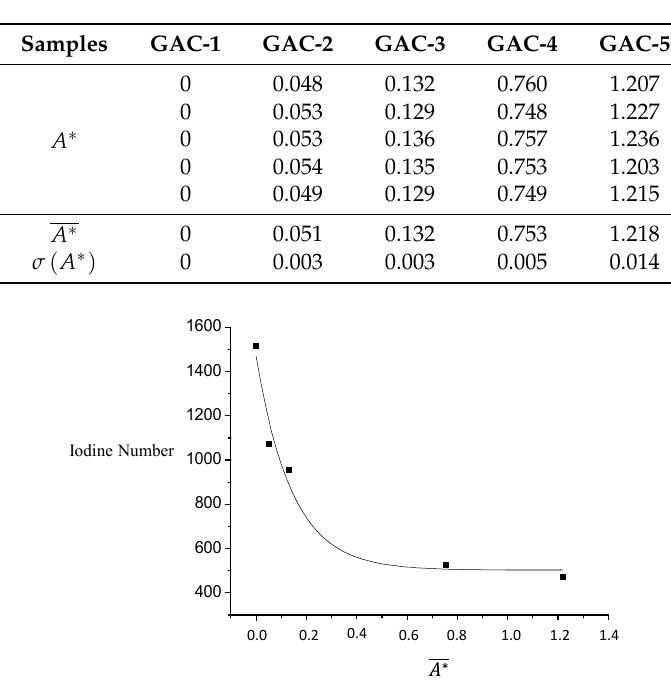
Table 10. A* values of the GAC samples.